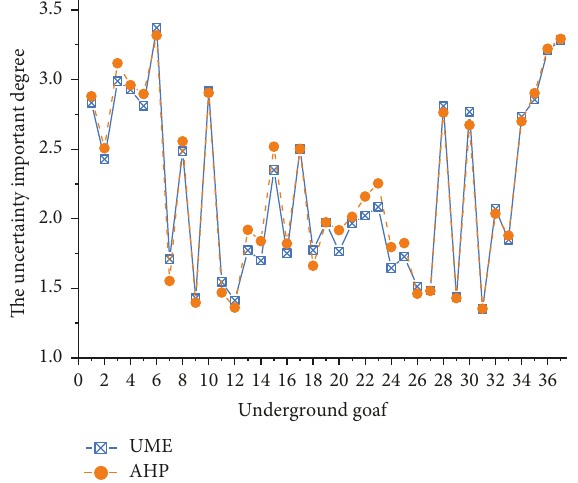
Figure 8: The comparison results for the uncertainty important degree of 37 underground goafs using UME and AHP, where the blue symbols represent values of 𝑞 UME and the orange symbols represent values of 𝑞 AHP